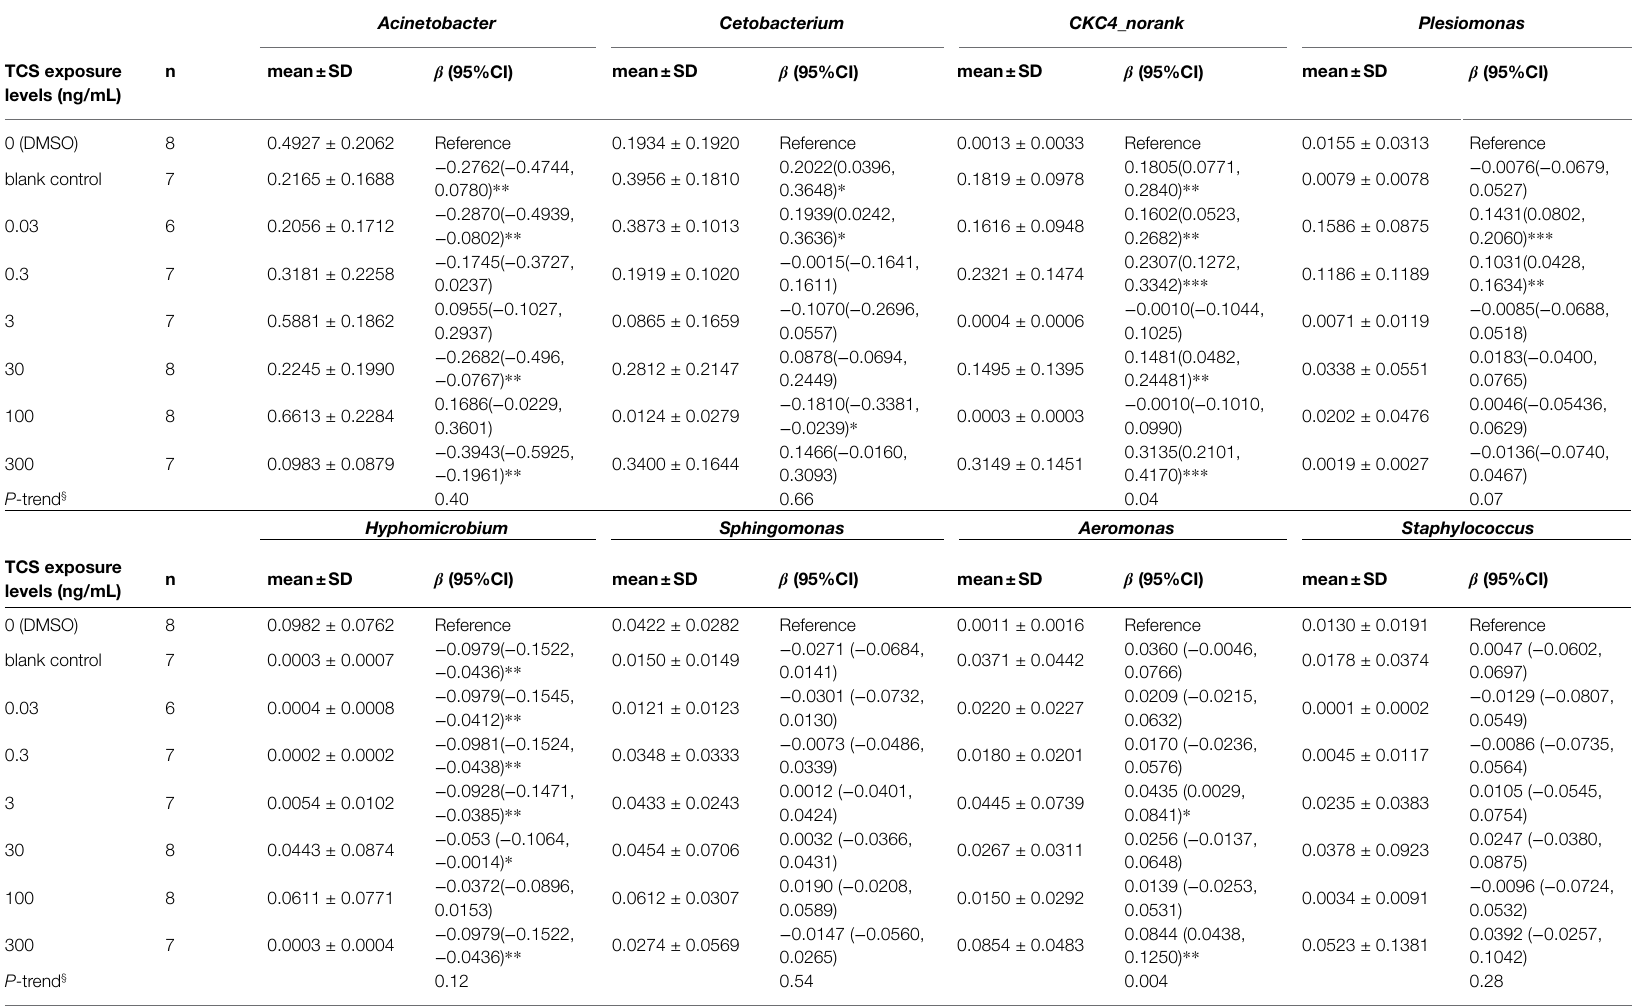
TABLE 2 | Effects of long-term TCS exposure on the relative abundance of the top 8 dominant microbiota in the gastrointestinal tract of zebrafish at the genus